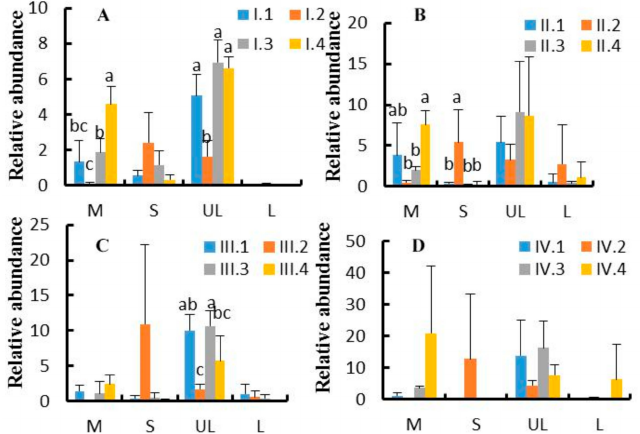
Figure 5. ( A – D ). E ff ects of dietary NFC / NDF ratio change on the relative abundance of ruminal genera. Figure 5A–D represent experimental periods I (1–18 d), II (19–36 d), III (37–54 d), and IV (55–72 d). Groups 1, 2, 3, and 4 represent four groups of Karakul sheep treated with four dietary NFC / NDF ratios of 0.54, 0.96, 1.37, and 1.90. In each graph, M = Mycoplasma ; S = Succiniclasticum ; UL = unidentified- Lachnospiraceae ; and L = Lactobacillus